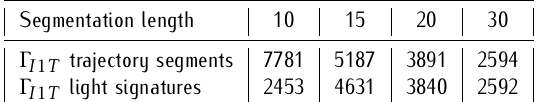
Figure 19. Measured light values for the Deva to Bucures Sibiu) segment of A1-DN7